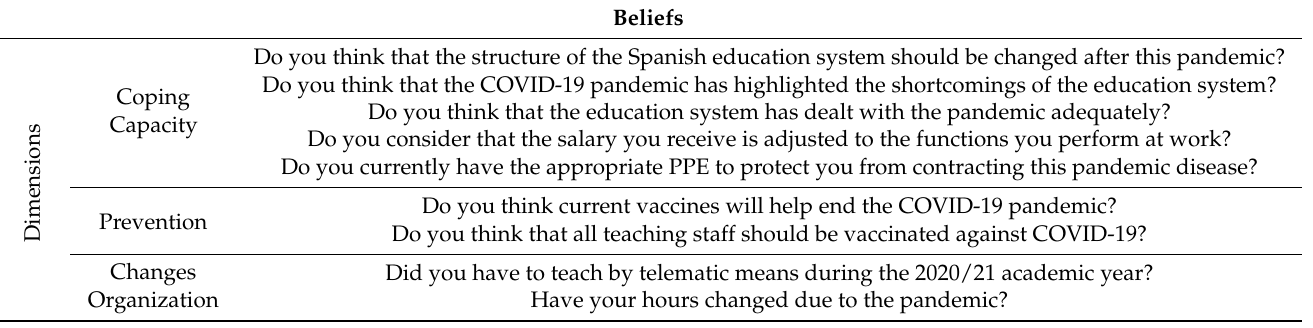
Table A1. Items distributed by dimensions and sections of the questionnaire.